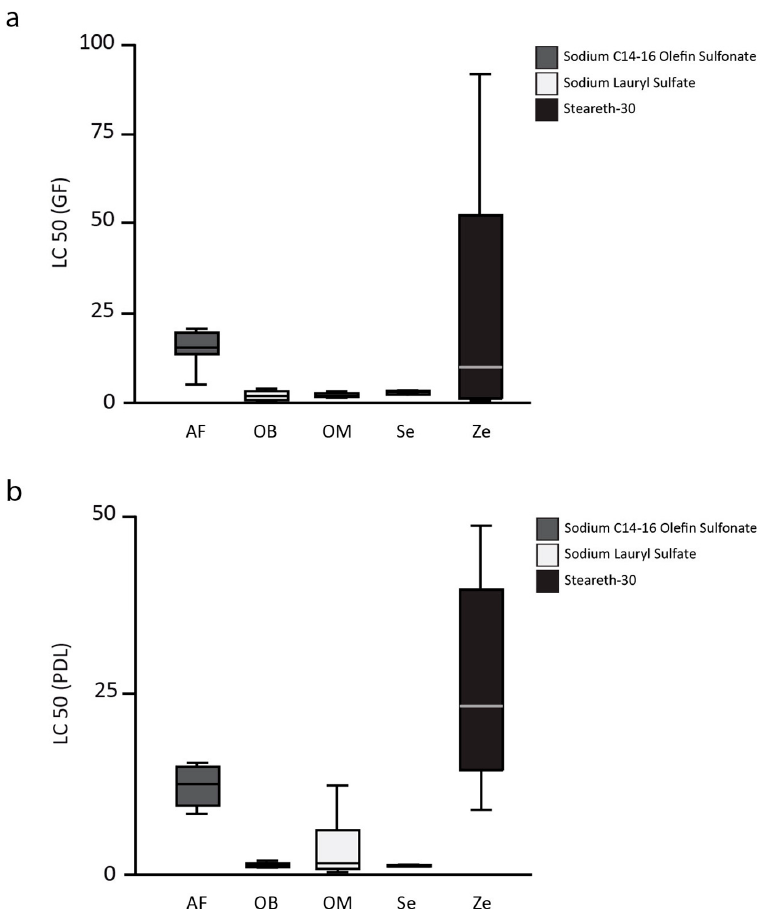
Figure 2. The half lethal concentration (LC50) of toothpaste ‐ conditioned medium (TCM) of the toothpastes (one experimental toothpaste, AirFlow AF, and four commercially available toothpastes, Zendium Ze, Sensodyne Se, OdolMed OM, and OralB OB) on gingival fibroblasts ( a ) and periodontal ligament fibroblasts ( b